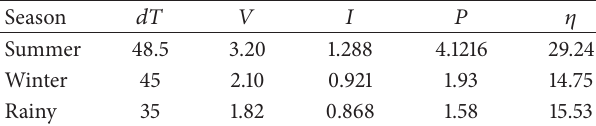
Table 2: Power and efficiency of the system at different seasons.